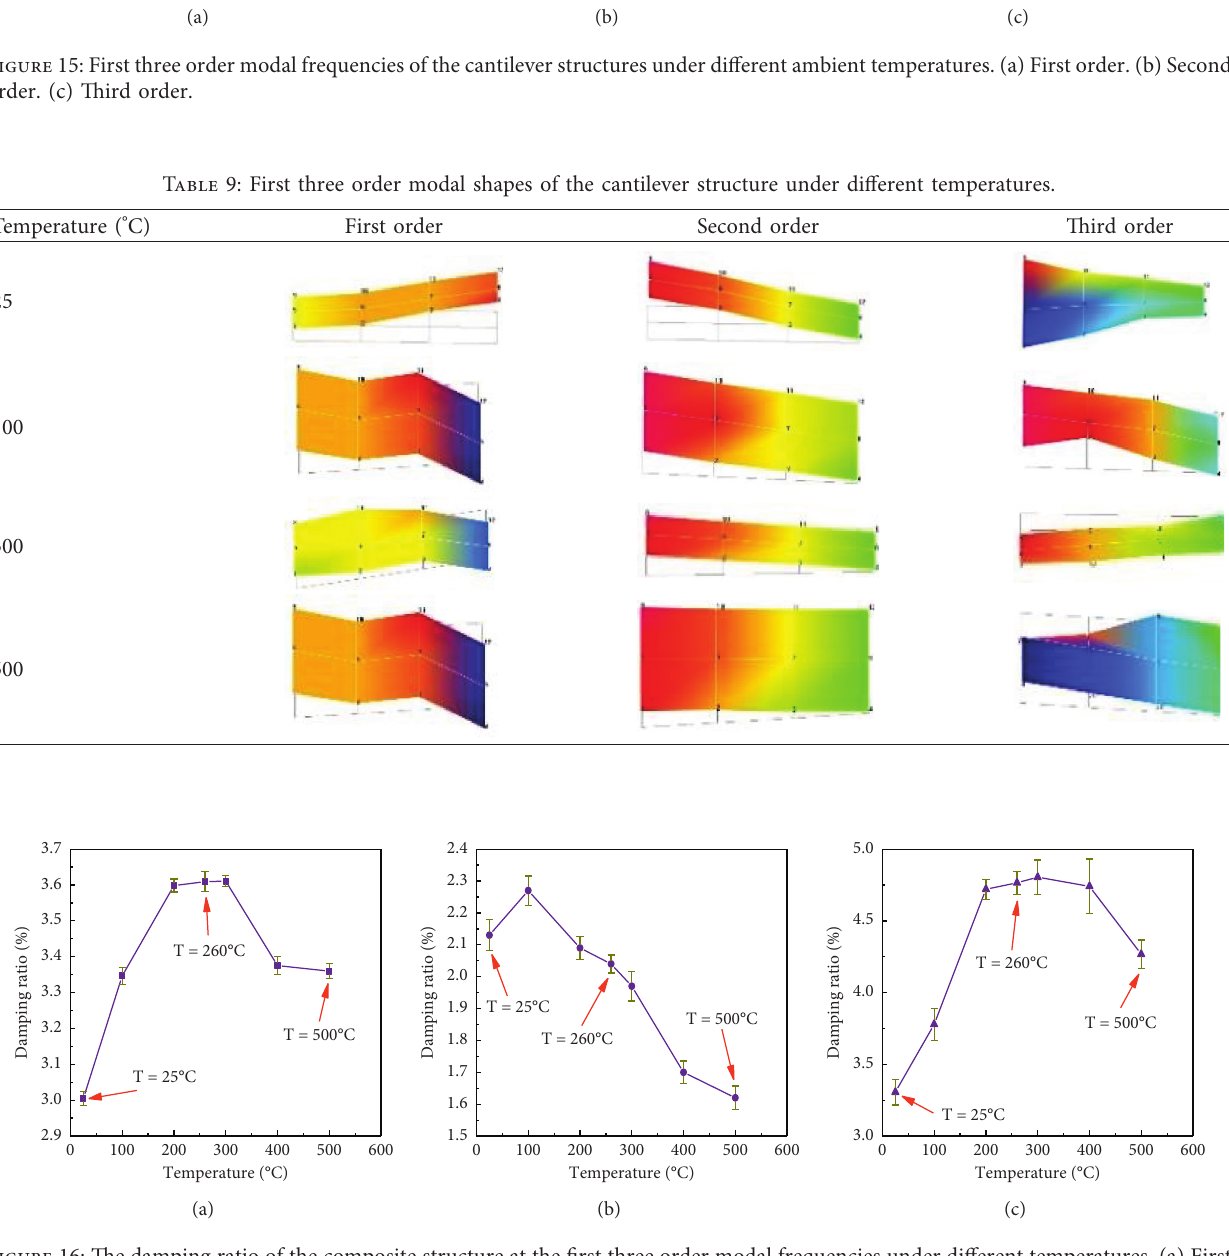
Figure 16: The damping ratio of the composite structure at the first three order modal frequencies under different temperatures. (a) First order. (b) Second order. (c) Third